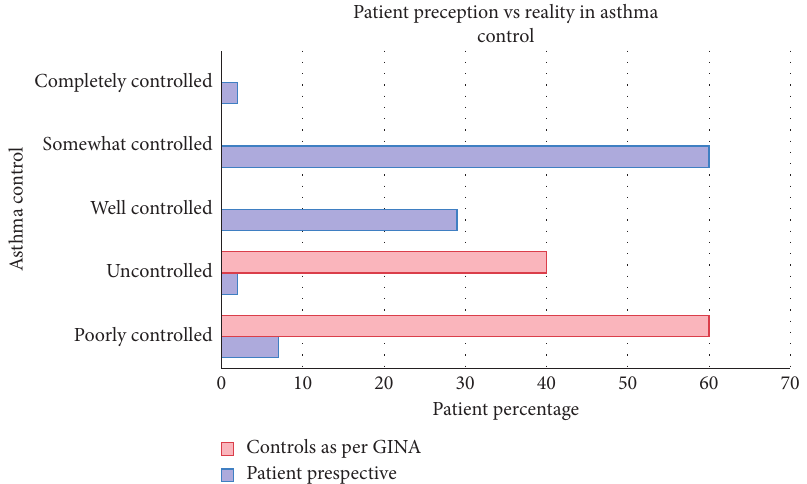
Figure 1: Control of asthma: patient perception versus GINA guideline-defined control.